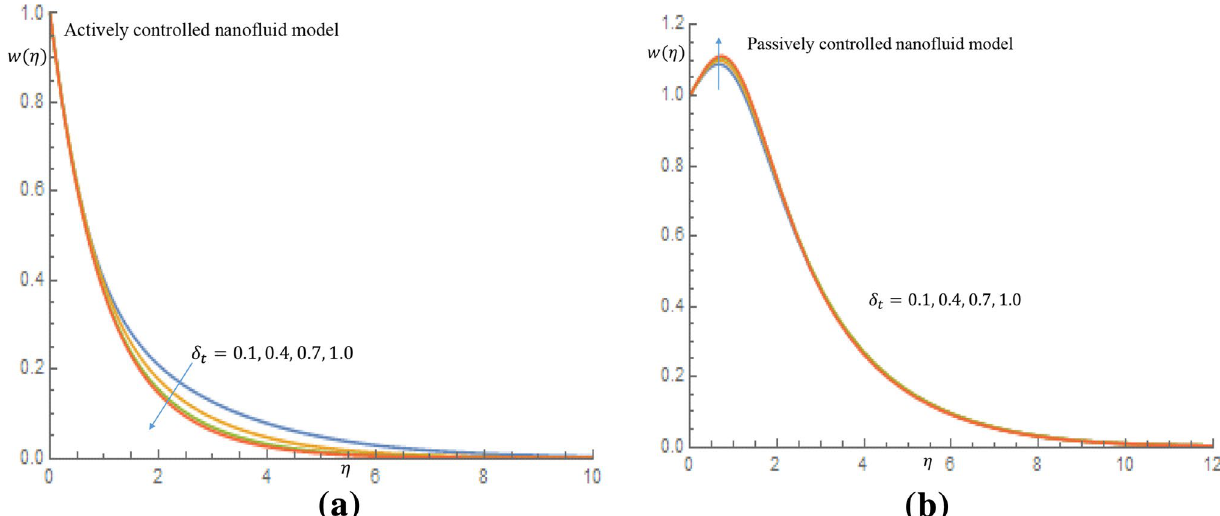
Figure 10. ( a ) Effect of δ t on density of motile microorganisms profile when K 1 = K 2 = 0 . ( b ) Effect of δ t on density of motile microorganisms profile when K 1 = K 2 = 0